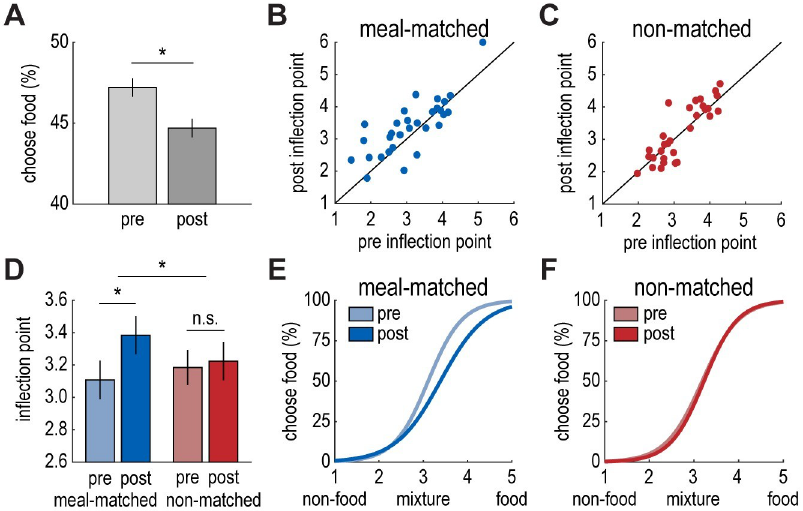
Fig 2. Satiety biases olfactory perceptual decision-making for meal-matched odors. (A) Participants were less likely to identify the food component as dominant in the mixture following the meal (t (29) = 2.19, p = 0.04). (B, C) Individual participant data depicting the inflection point of the sigmoidal function pre- and post-meal for the meal-matched (B) and non-matched (C) odor pairs. (D) The sigmoidal inflection point increased significantly from before to after the meal for the meal-matched odor pair (t (29) = 2.66, p = 0.01), indicating a bias away from the food odor. This was not the case for the non-matched odor pair (t (29) = 0.49, p = 0.63). Inflection points increased more for the meal-matched odor pair compared to the non-matched odor pair (t (29) = 1.92, p = 0.03, 1-tailed). (E, F) Perceptual choice curves (with parameters reflecting the mean inflection point and slope across participants) illustrating the average shift in the inflection point from pre- to post-meal for meal-matched (E) and non-matched (F) odor pairs. Error bars depict within-subject SEM for n = 30. Individual participant data summarized in these plots can be found in S1 Data . SEM, standard error of the